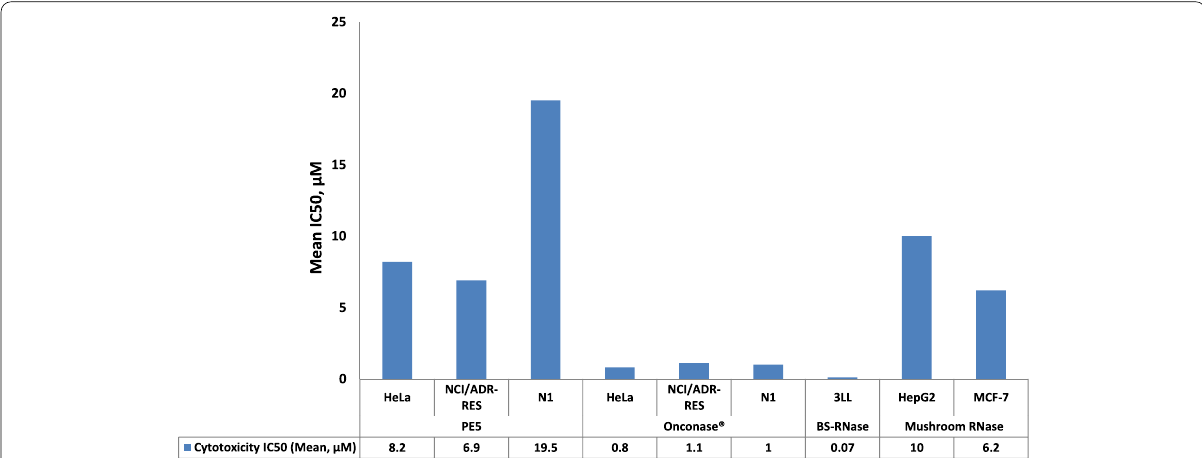
Fig. 4 Cytotoxicity of eukaryotic RNases on cancerous and non-cancerous cell lines. PE5—nuclear directed human pancreatic RNase and BS-RNase – bovine seminal ribonuclease. HeLa – cervical cancer cell line, NCI/ADR-RES – drug resistant ovarian cancer cells, N1 – normal human fibroblast cells, 3LL – Lewis lung metastasis cells, HepG2 – human liver cancer cells and MCF-7 – Breast cancer